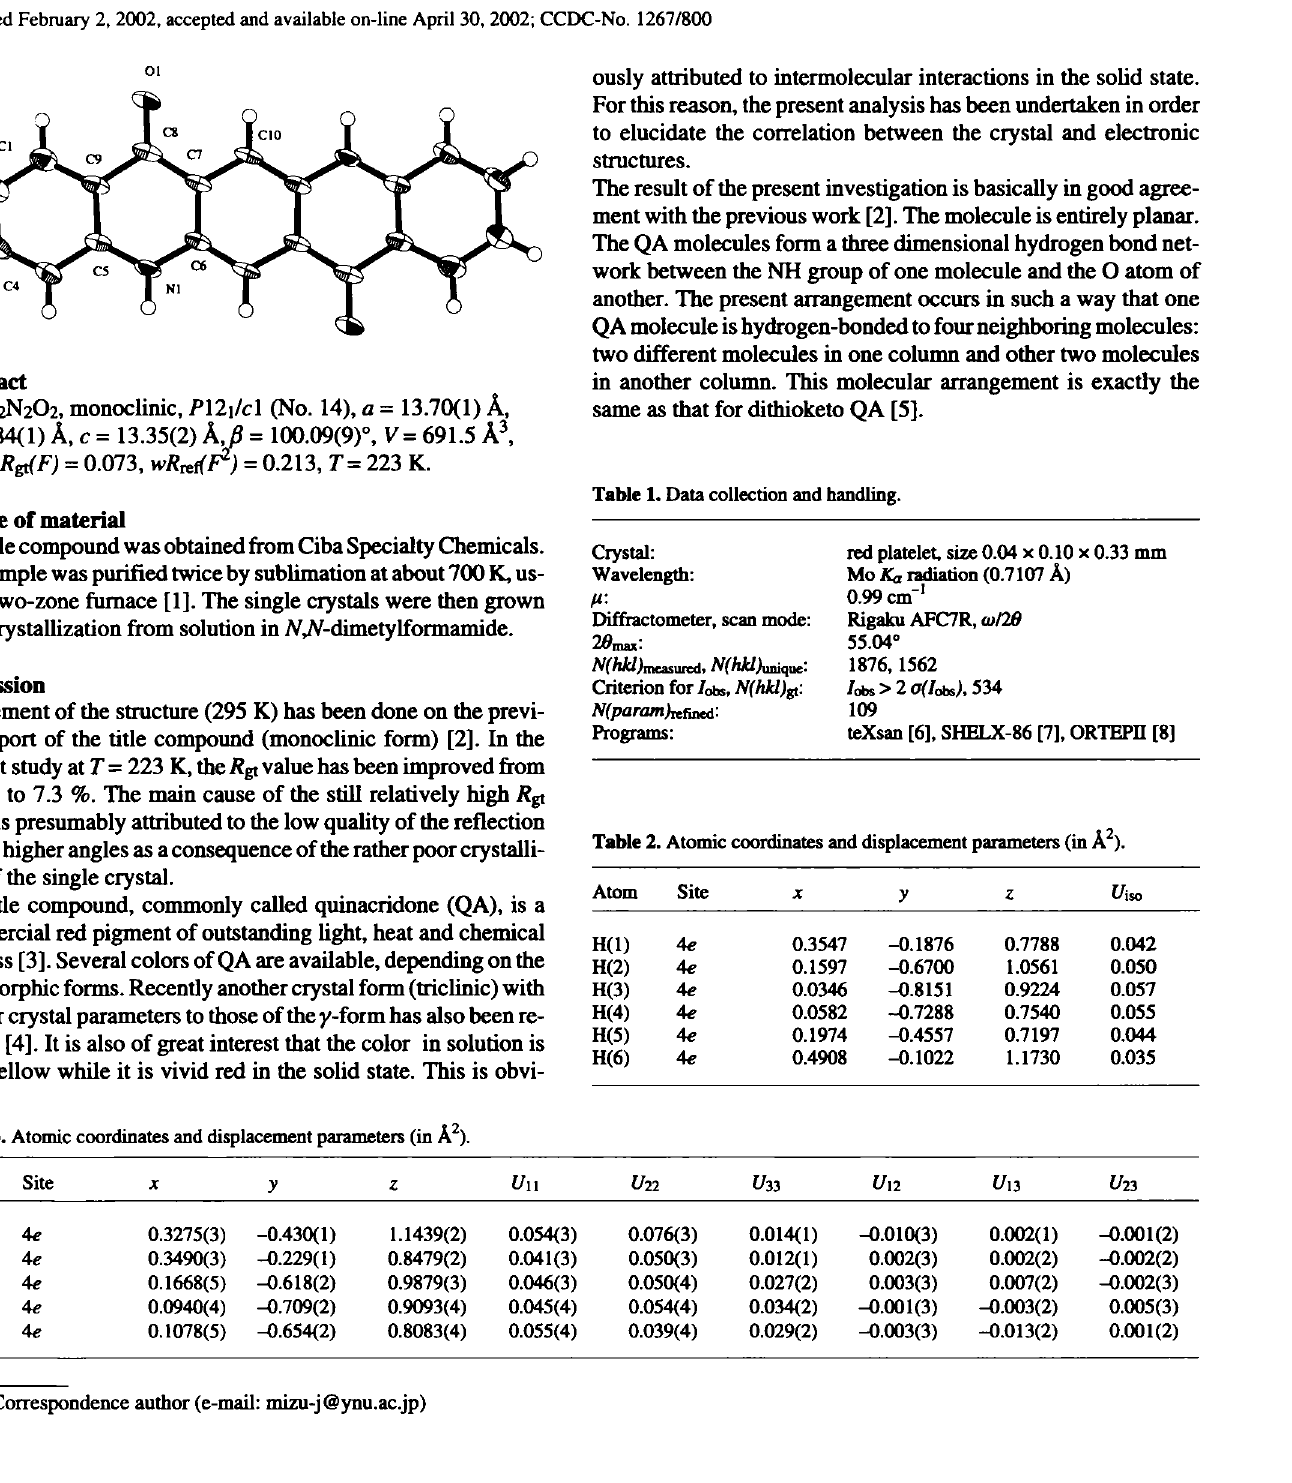
Table 1. Data collection and handling.